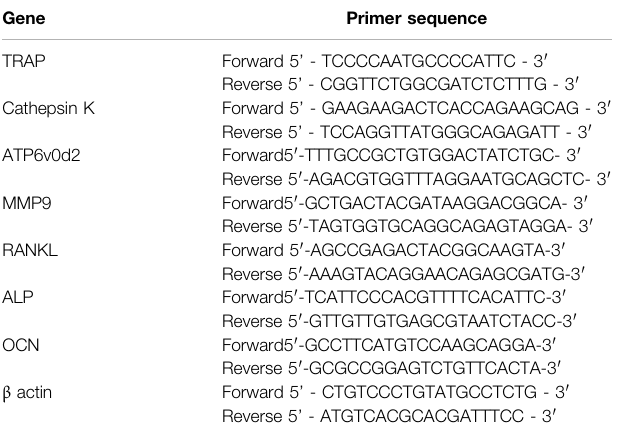
TABLE 1 | Sequences of all primers in quantitative RT-PCR analysis. Gene Primer